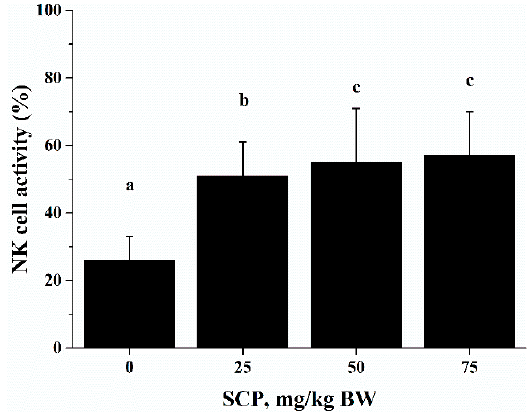
Figure 4. Effect of SCP on natural killer (NK) cells activity in C57BL/6 mice. Mice received daily oral gavage of SCP at 0, 25, 50 or 75 mg/kg body weight for eight weeks. NK activity was determined as percent cytolytic killing of K562 cells (target cells) by splenocytes (effector cells) using a flow cytometry method. Values are means ± SD, n = 10. For each variable, means in a row without a common letter significantly differ as determined by one-factor ANOVA, p < 0.05.